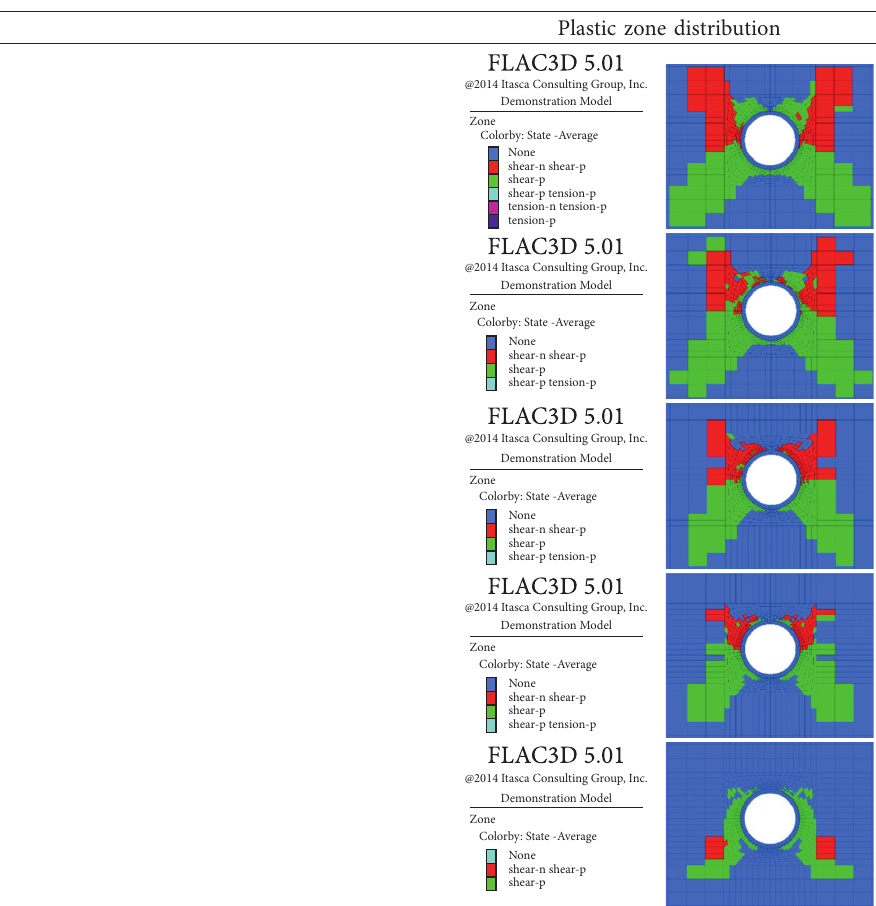
Figure 12: Changes of segment convergence without backfill grouting. Table 14: Distribution of soil plastic zone without backfill